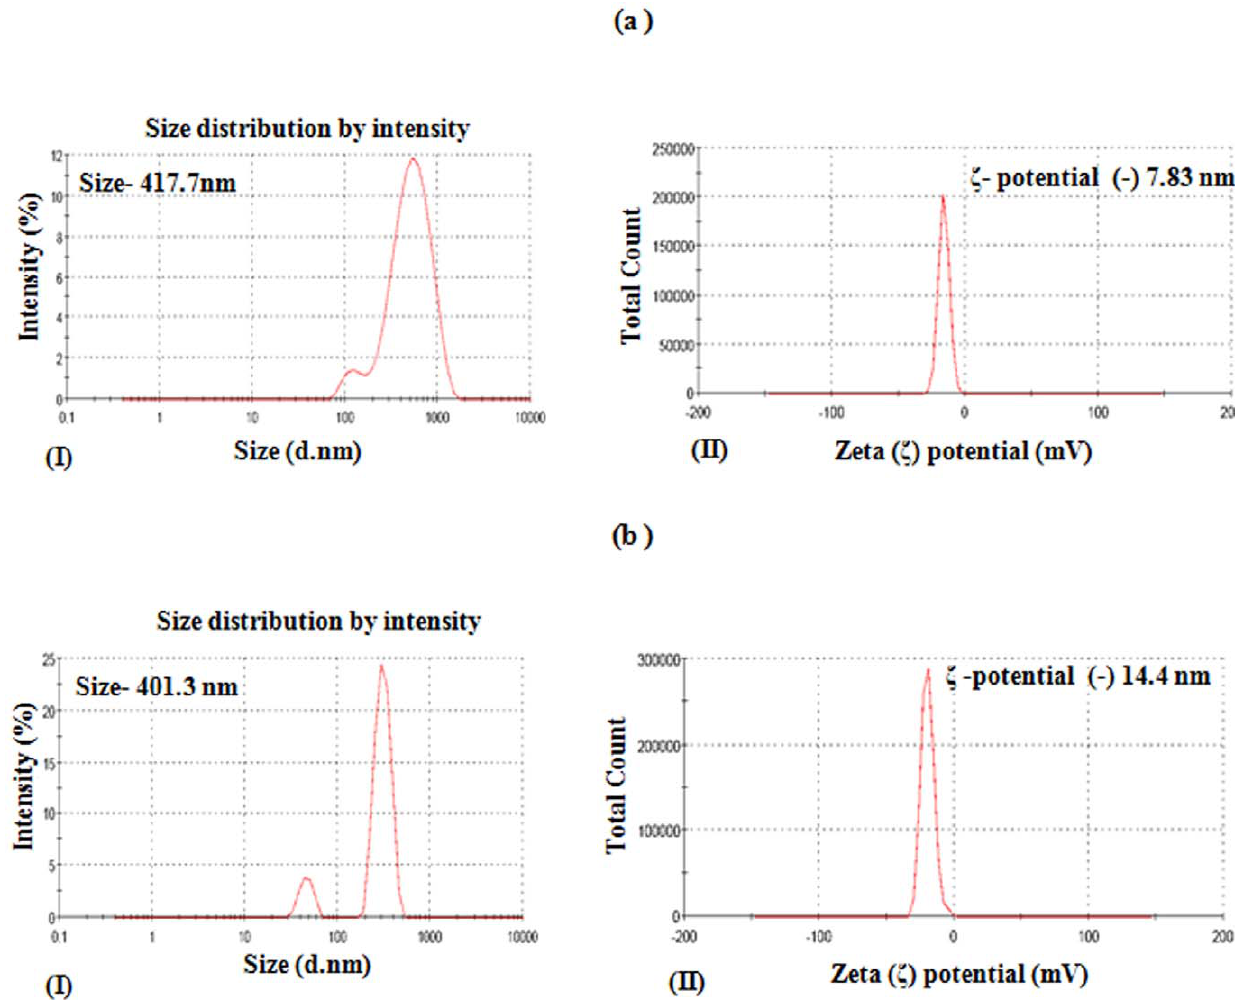
Figure 1. Characterization of TiO 2 -NPs and MWCNTs using Dynamic Light Scattering. Size distribution and zeta potential of TiO 2 -NPs (a, I & II) and MWCNTs (b, I & II) were determined using dynamic light scattering and phase analysis light scattering (PALS) in a Zetasizer Nano-ZS, Model ZEN3600.